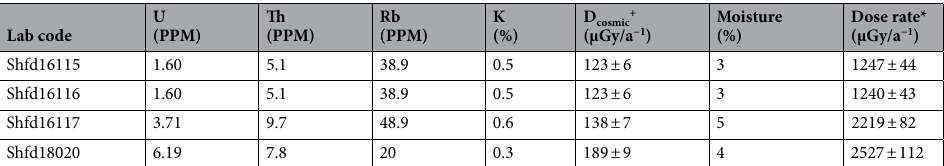
Table 1. Summary of results for dosimetry data. + Cosmic dose is calculated as a linear decay curve at depths below 50 cm. Above this depth, errors in calculation may lead to an under-estimation of the cosmic dose contribution. * Total Dose is attenuated for grain size, density and moisture.